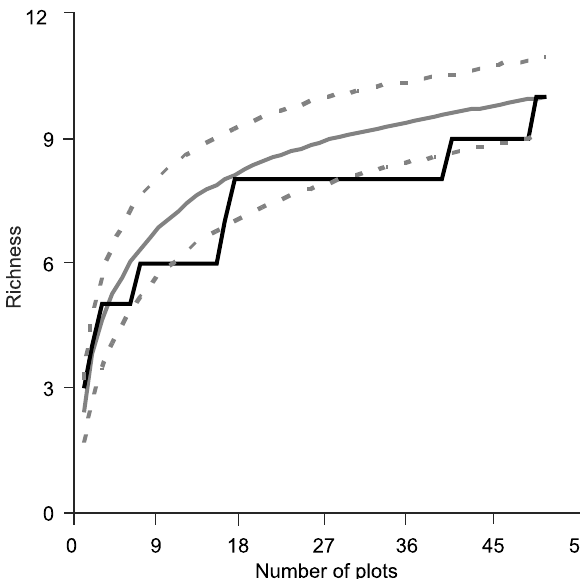
Figure 1. Cumulative (black line) and rarefaction (solid gray line; with the standard deviation represented by dotted gray lines) curves of richness of leaf litter frogs recorded at the Atlantic rainforest of Reserva Ecológica de Guapiaçu, in southeastern Bra- zil, using 5 x 5 plot sampling method.